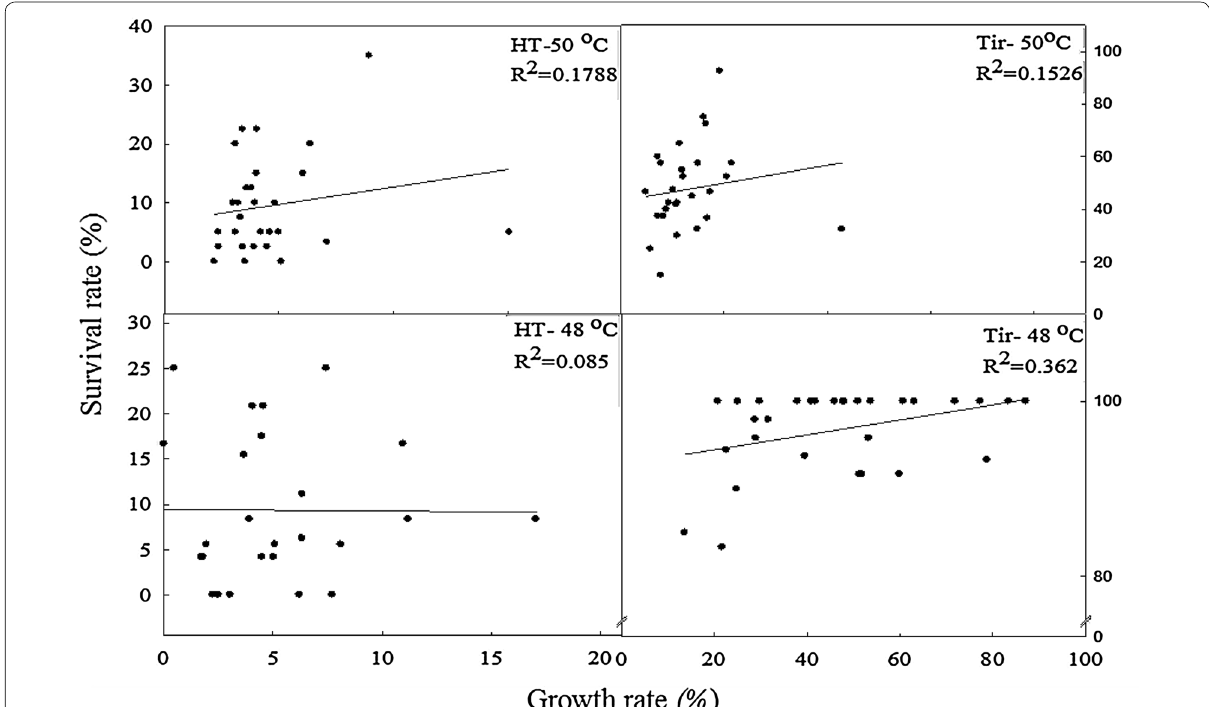
Fig. 1 Correlation between seedling survival rate and shoot RGR under different HT and TIR treatments. Dots in the figure indicate varieties tested in this study and there are 27